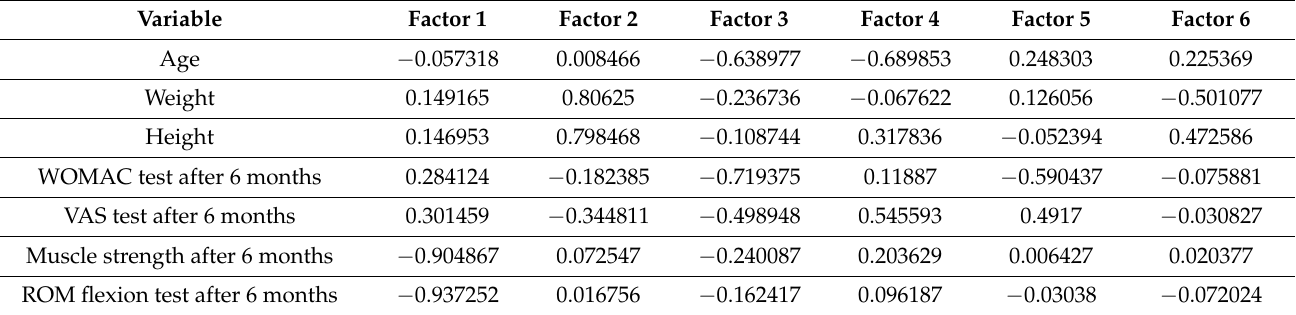
Table 12. Factor coordinates of the variables based on correlations for the pilot group (PG) after 6